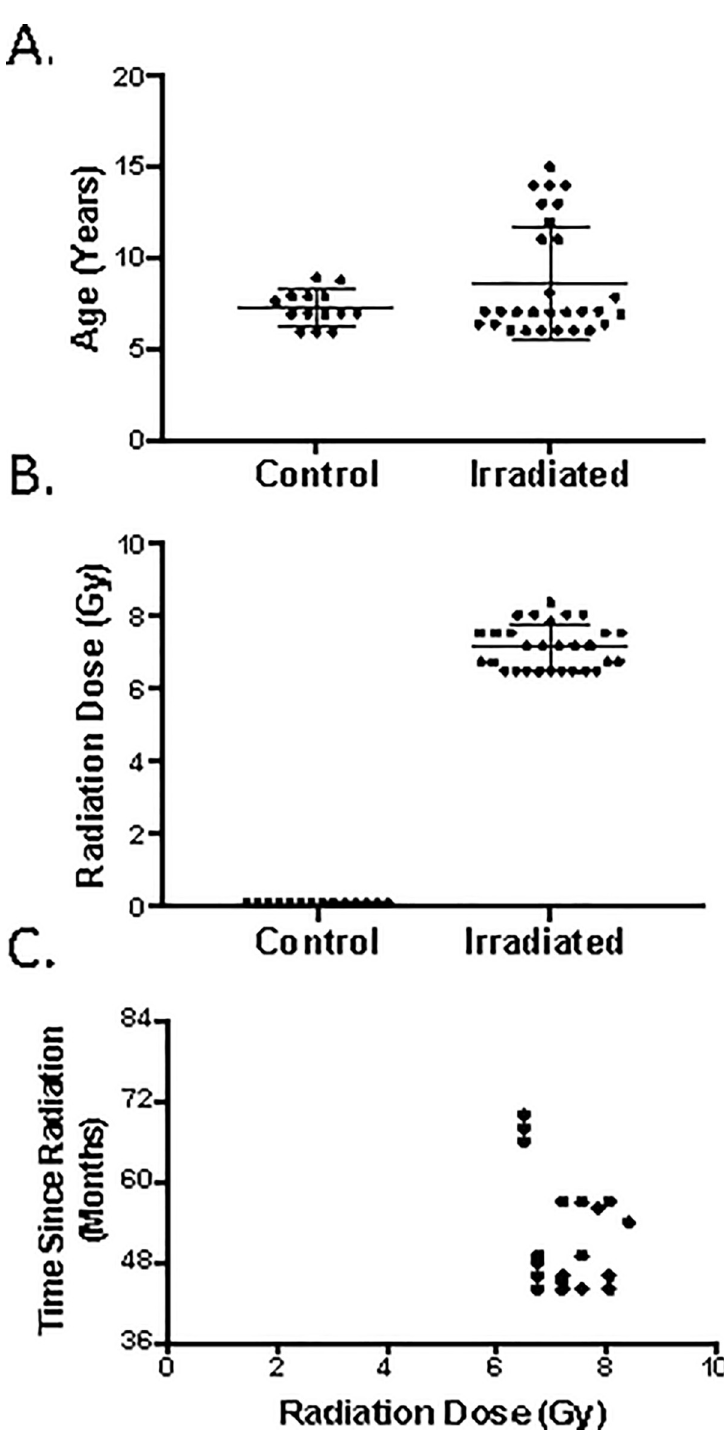
Fig 1. Demographics of the non-human primate population studied. A . The ages are shown for control (n = 14) and irradiated animals (n = 29) in the X-10-12 cohort. The median age of 7 years was similar for both groups, with a range from 5.9 to 8.9 years for the control group and a range of 6 to15 years for the irradiated group. B . The median dose (Gy) received by irradiated animals was 7.2 Gy, with a range of 6.5 to 8.4 Gy. C. The median time between radiation exposure and study/blood collection was 55 months, with a range from 44 to 70